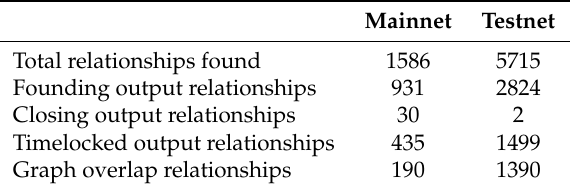
Table 4. Relationships found between channel graphs using heuristic one and